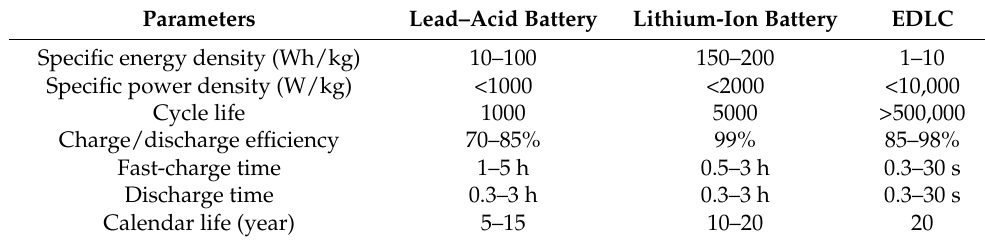
Table 1. EDLC comparison with other ESDs